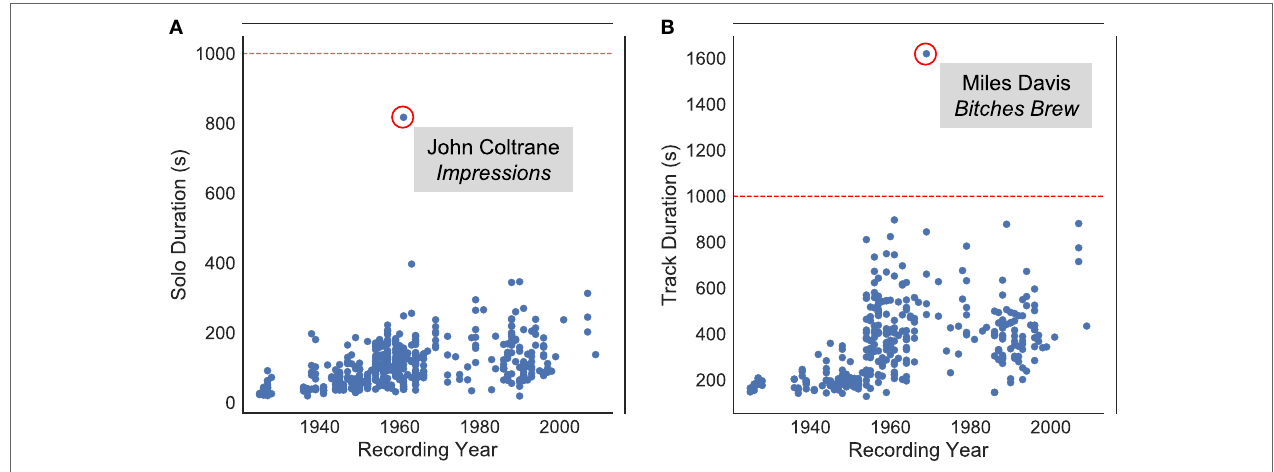
FigUre 2 | (a) 456 solos and (B) 343 tracks considered in the WJD, represented according to their duration and respective recording years. The dashed lines indicate the limits for the maximum duration of the considered YouTube videos.